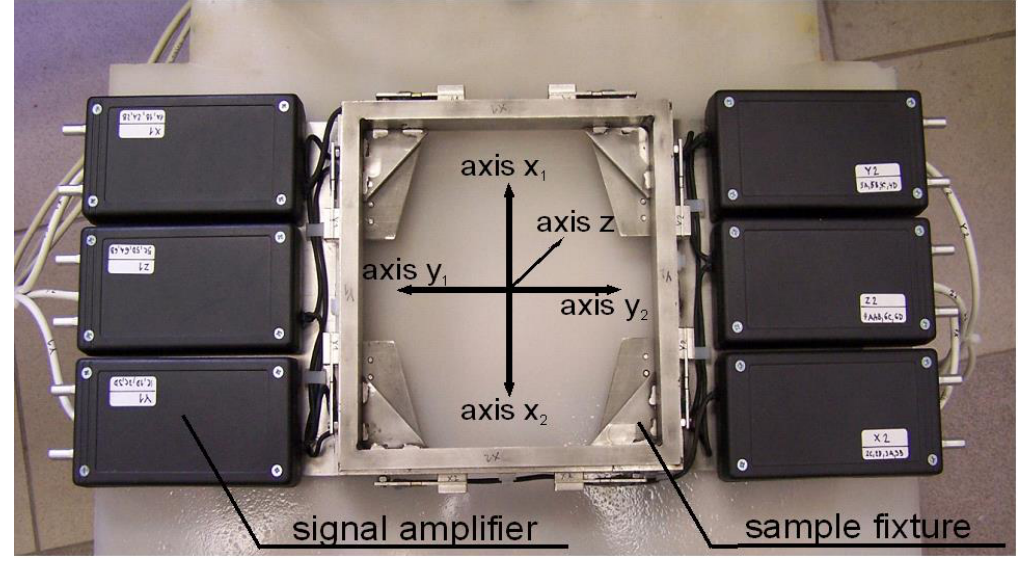
Figure 3. Overall view of the force sensor–black boxes contain amplifiers for strain gauges.